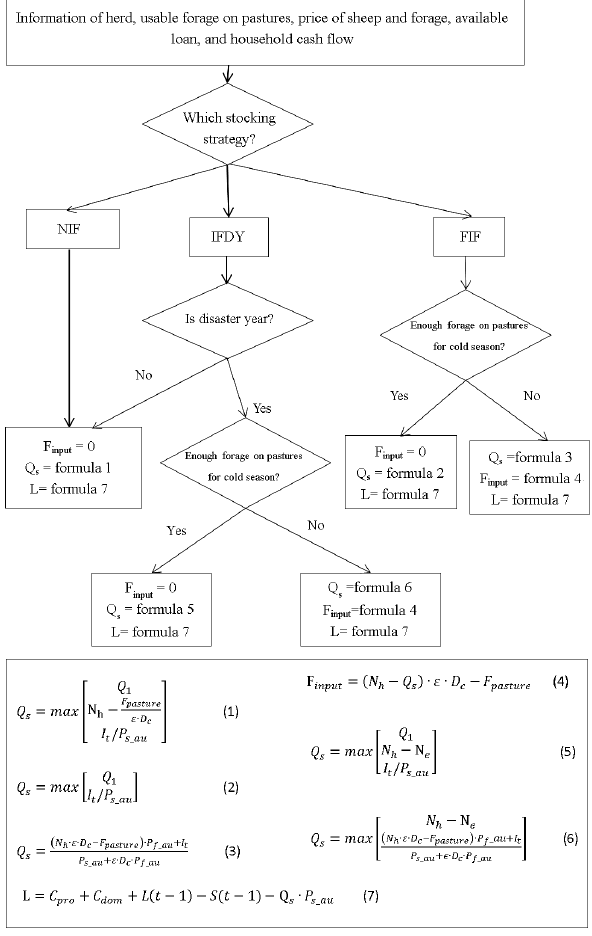
Fig. 3 . Flow chart of the processes of the agents’ stocking decision. With input of information, the agents with different fodder strategies decide the amount of livestock to sell, forage to buy, and credit loan to borrow according to the decision process and the formulas. NIF - no import of forage, FIDY - import of forage only in disaster years, FIF - import of forage whenever forage gaps exist, Finput - amount of purchased fodder, Os - total number of sheep for sale, L - amount of credit loan to borrow, Fpasure - usable forage on the pasture in cold season., Nh - total number of sheep, Q1 - number of sheep for sale at first stage, is the sum of the number of old, sick, and male lambs. ε - daily forage intake per sheep, Dc - total days in cold season, It - target income, It = total production costs before fodder purchase + living expenditures + savings in previous year + loan (if exists) in the previous year - available loan, Ps_au - price of sheep in autumn, Pf_au - price of fodder in autumn, Ne - number of ewes at the beginning of the year. Cpro - production costs, Cdom - family expenditures, L (t-1) - loans in the previous year, S(t-1) - savings in the previous year. Detailed explanations of the formulas are provided in Appendix